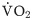
Baseline FEV1 (%pred) and peak V˙O2 (%pred) relationship.Moderate linear relationship (r = 0.63, p<0.0001) is demonstrated for cystic fibrosis (CF) patients (gray circles) while weak linear relationship (r = 0.23, p = 0.1) for the non-CF patients (black circles).